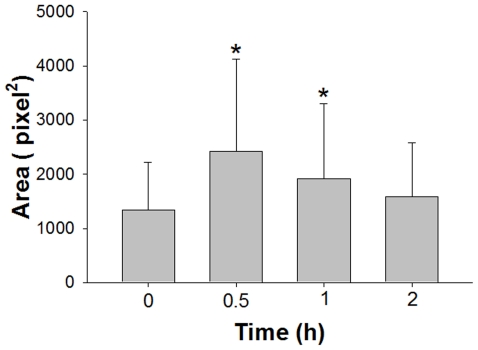
Stretch-induced spreading of cells.Cell spreading was quantified by measuring the area of cells from phase contrast images of cells at time 0, 0.5 h, 1 h, and 2 h after the start of stretch. Bar graphs represent means ± SD (n = 4). *: Significantly different (P<0.05) from the value with unstretched controls (time 0).